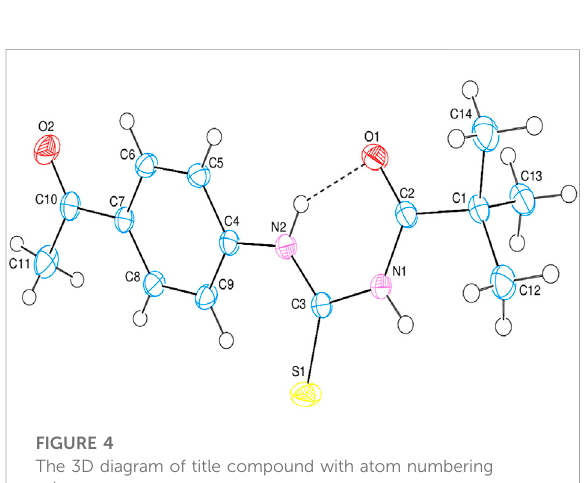
FIGURE 4 The 3D diagram of title compound with atom numbering scheme.